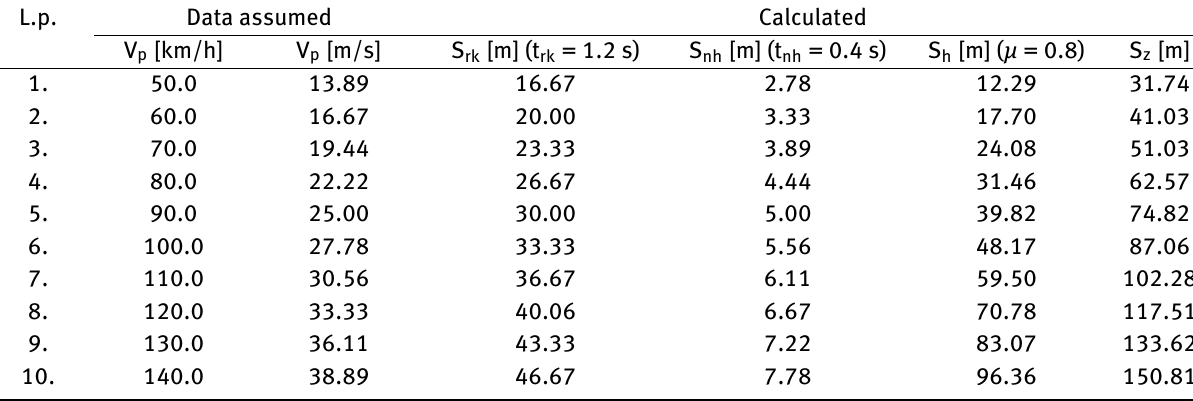
Table 1: Values of the size of the components of the stopping distance depend on the speed value car (for µ = 0.8, t rk = 1.2 s, t nh = 0.4 s)